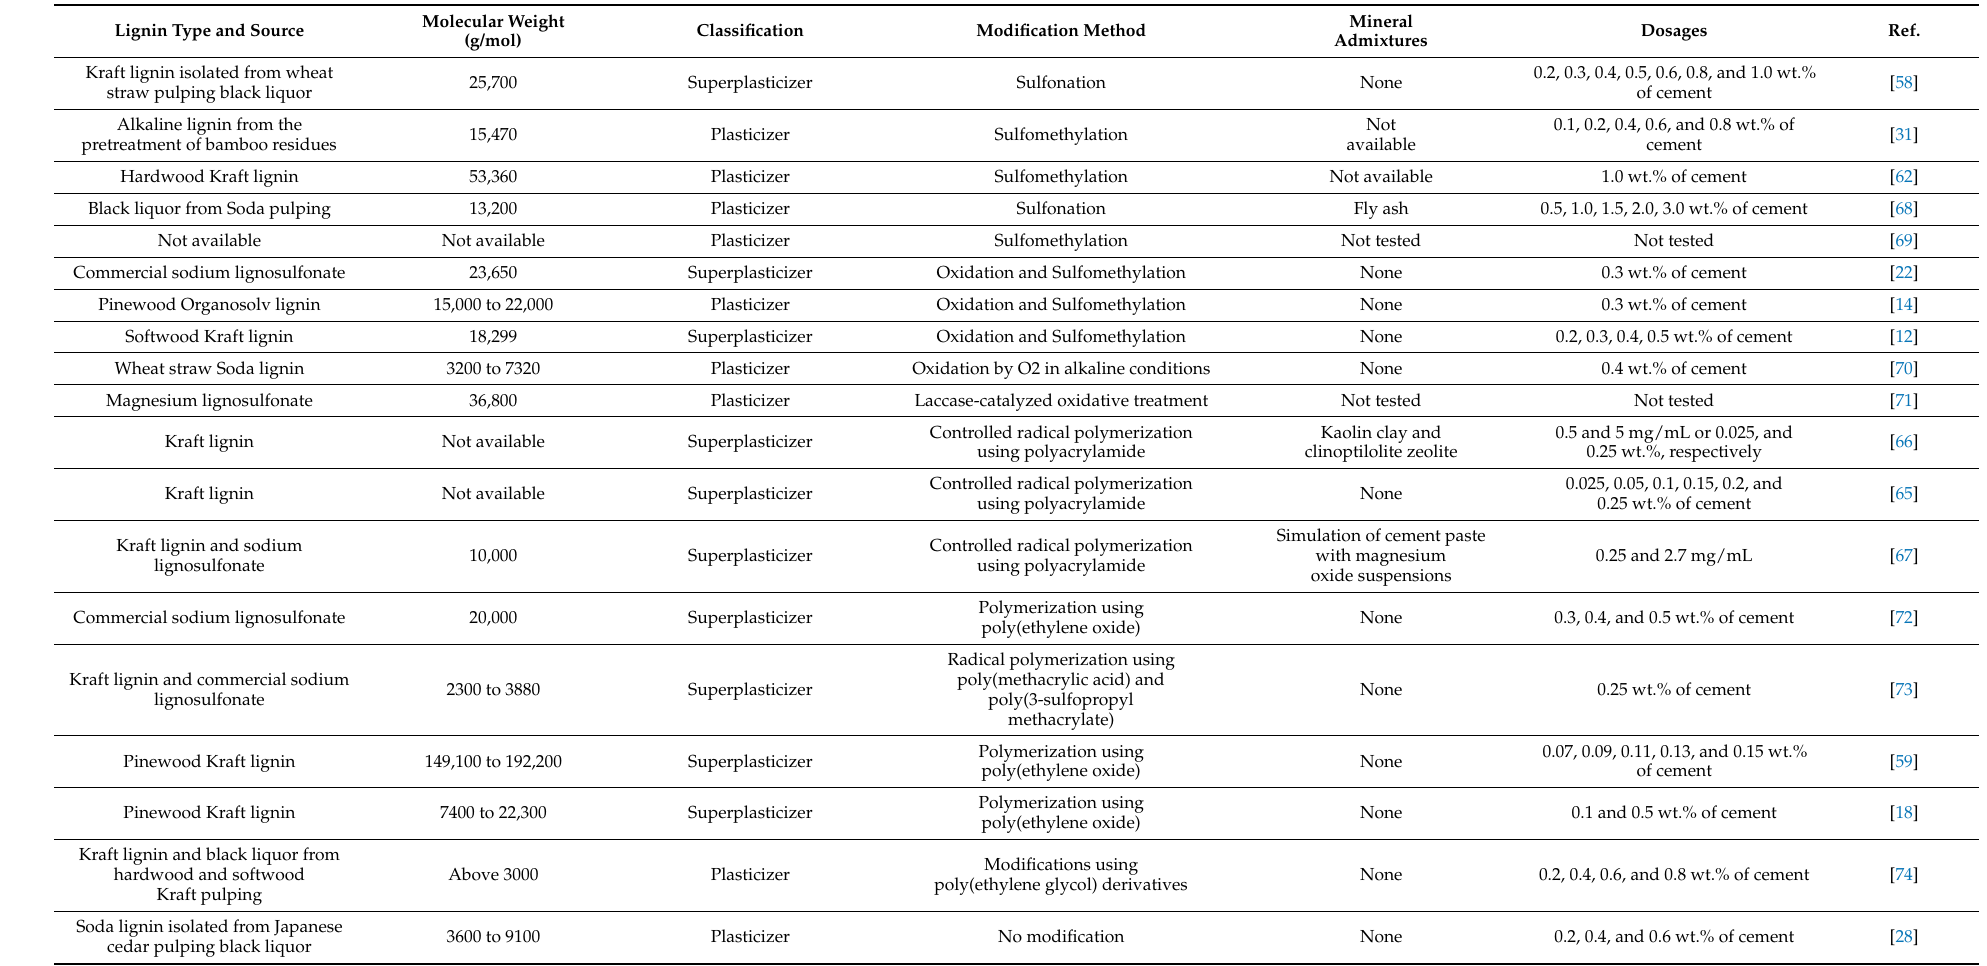
Table 6. Studies on new LBAs for cement-based